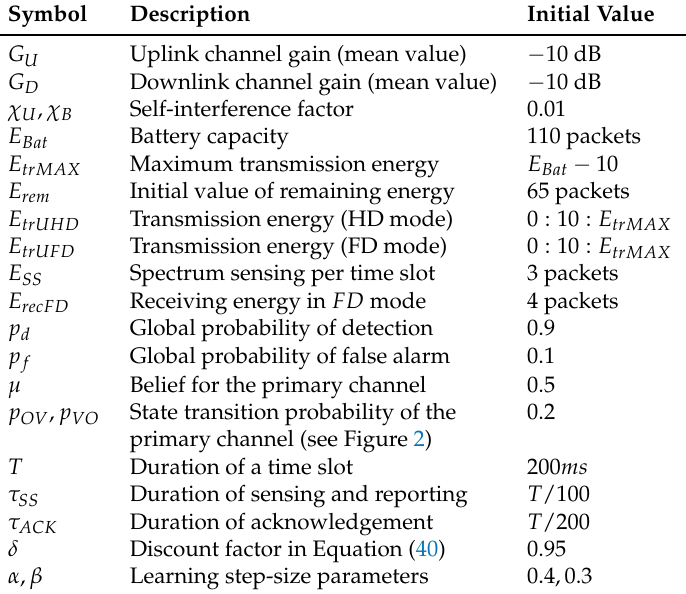
Table 1. Simulation Parameters.